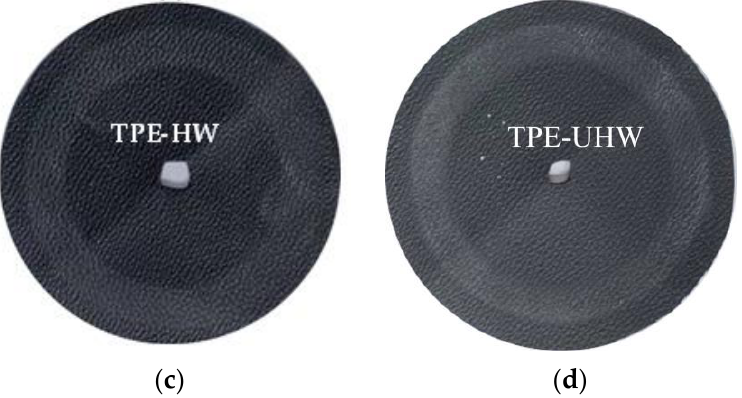
Figure 2. TPE samples after Taber abrasion test of TPE prepared by SEBS with similar structures and various molecular weight. ( a ) TPE-LW; ( b ) TPE-MW; ( c ) TPE-HW; ( d ) TPE-UHW.